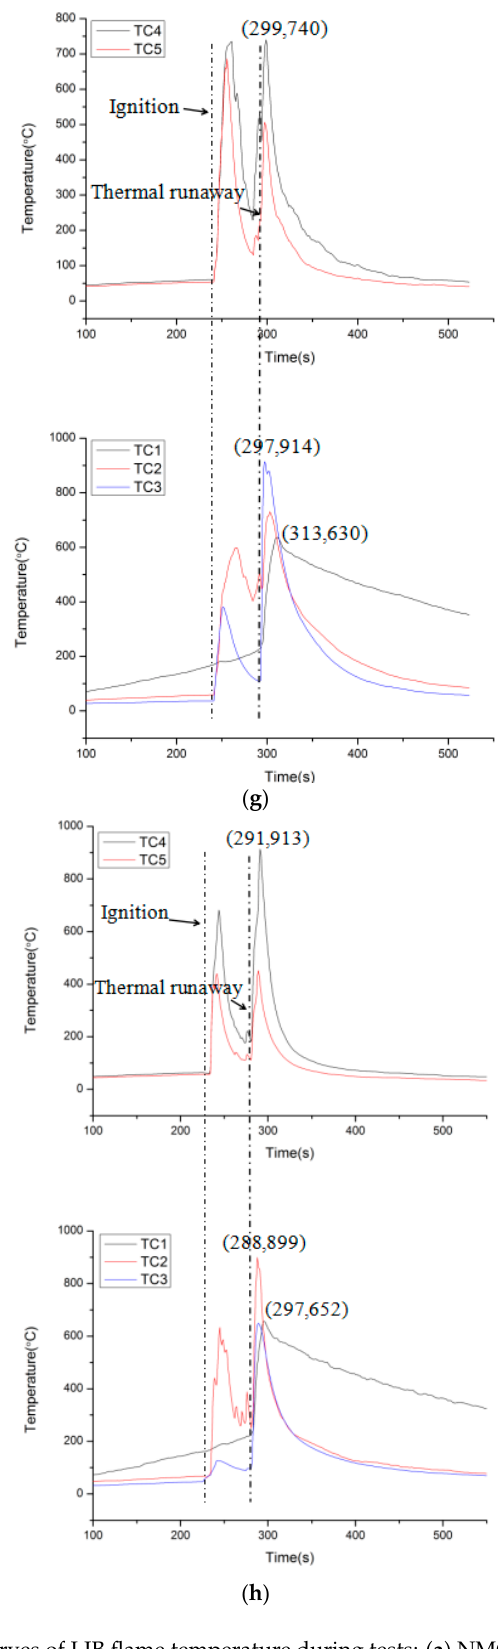
Figure 10. The typical curves of LIB flame temperature during tests: ( a ) NMC (4.2 V); ( b ) NMC (4.5 V); ( c ) NMC (4.8 V); ( d ) NMC (5.0 V); ( e ) LFP (4.2 V); ( f ) LFP (4.5 V); ( g ) LFP (4.8 V); ( h ) LFP (5.0